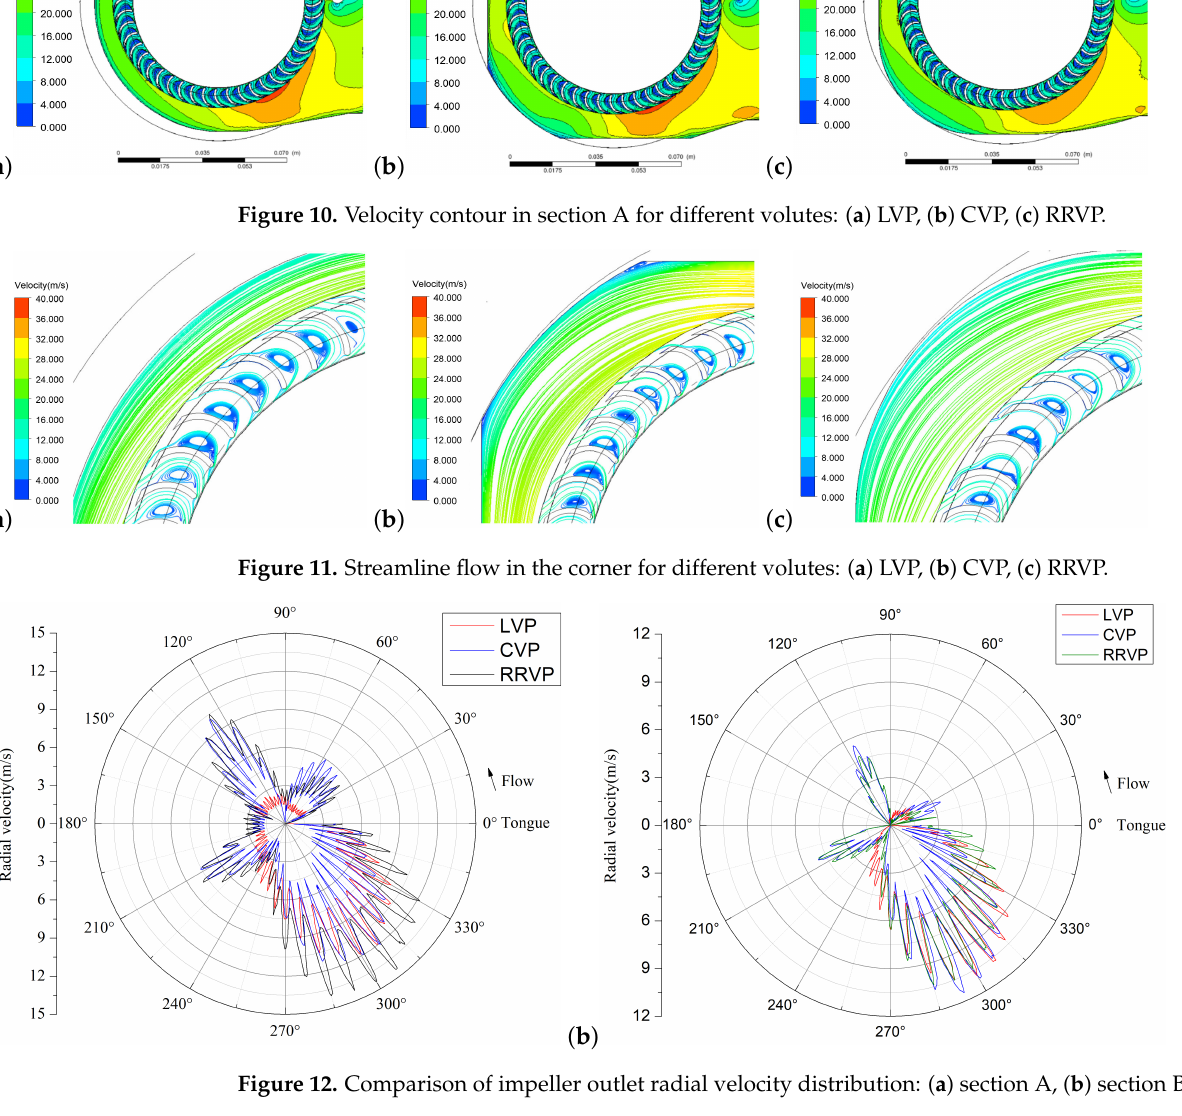
Figure 12. Comparison of impeller outlet radial velocity distribution: ( a ) section A, ( b ) section